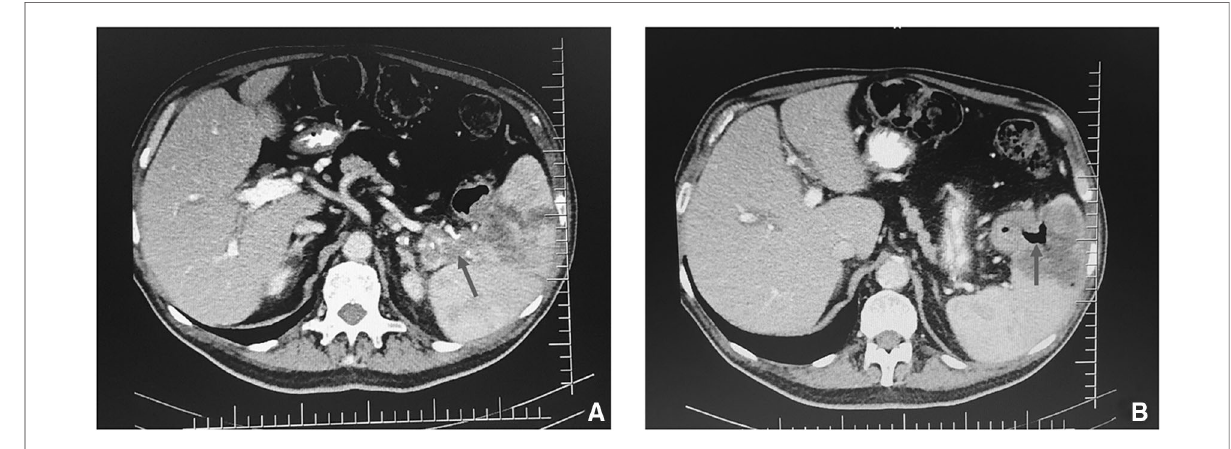
FIGURE 1 CT scan of the thorax and abdomen showing ( A ) suspicious fi stulous tract between colon and spleen (arrow) and ( B ) air in the spleen